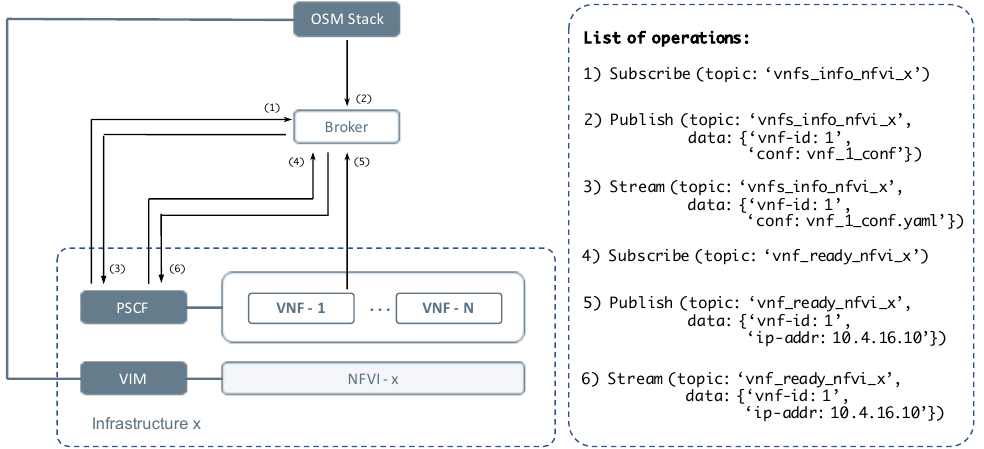
Figure 7. Flow diagram of VNF configuration solution based on the publish–subscribe